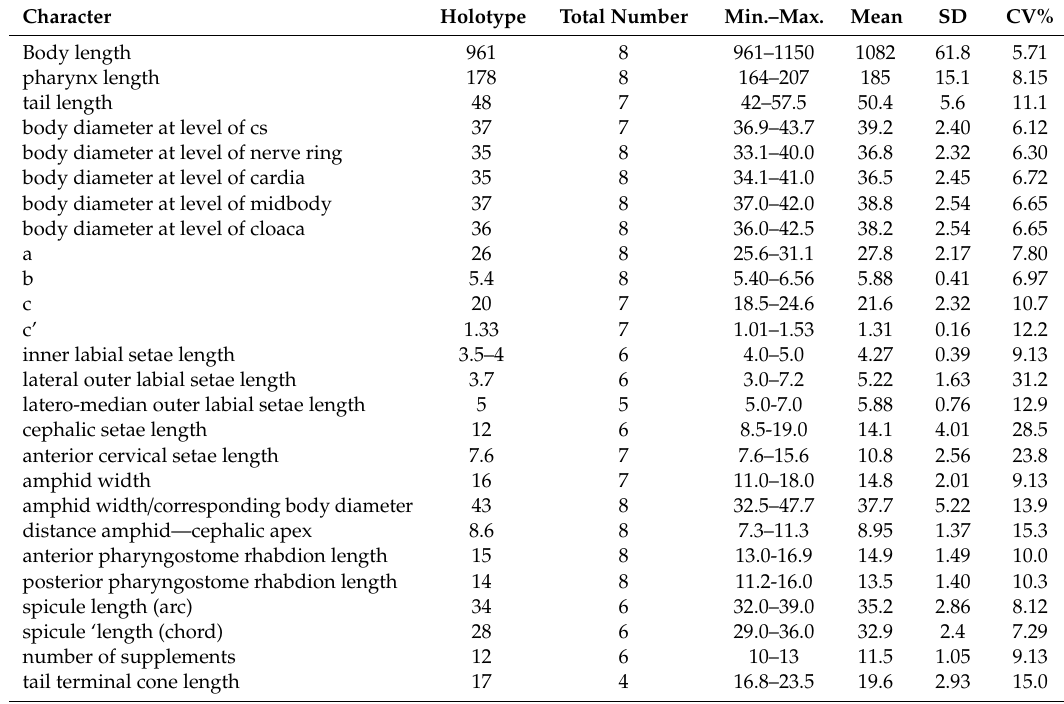
Table 3. Morphometrics of males Gammanema okhlopkovi sp. n. (holotype and